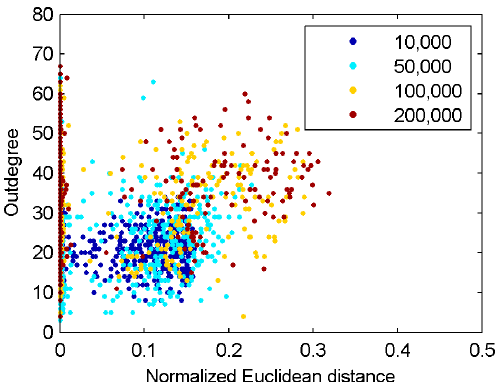
Figure 7. Relationship of outdegree vs. normalized Euclidean distance at 1,000th time step in Fig. 2 A. Scatter plot of the perturbed neurons’ outdegrees and the corresponding normalized Euclidean distances between the excitatory weight matrices. Coeffi- cients of correlation between the outdegree and the normalized Euclidean distance are not significantly different from